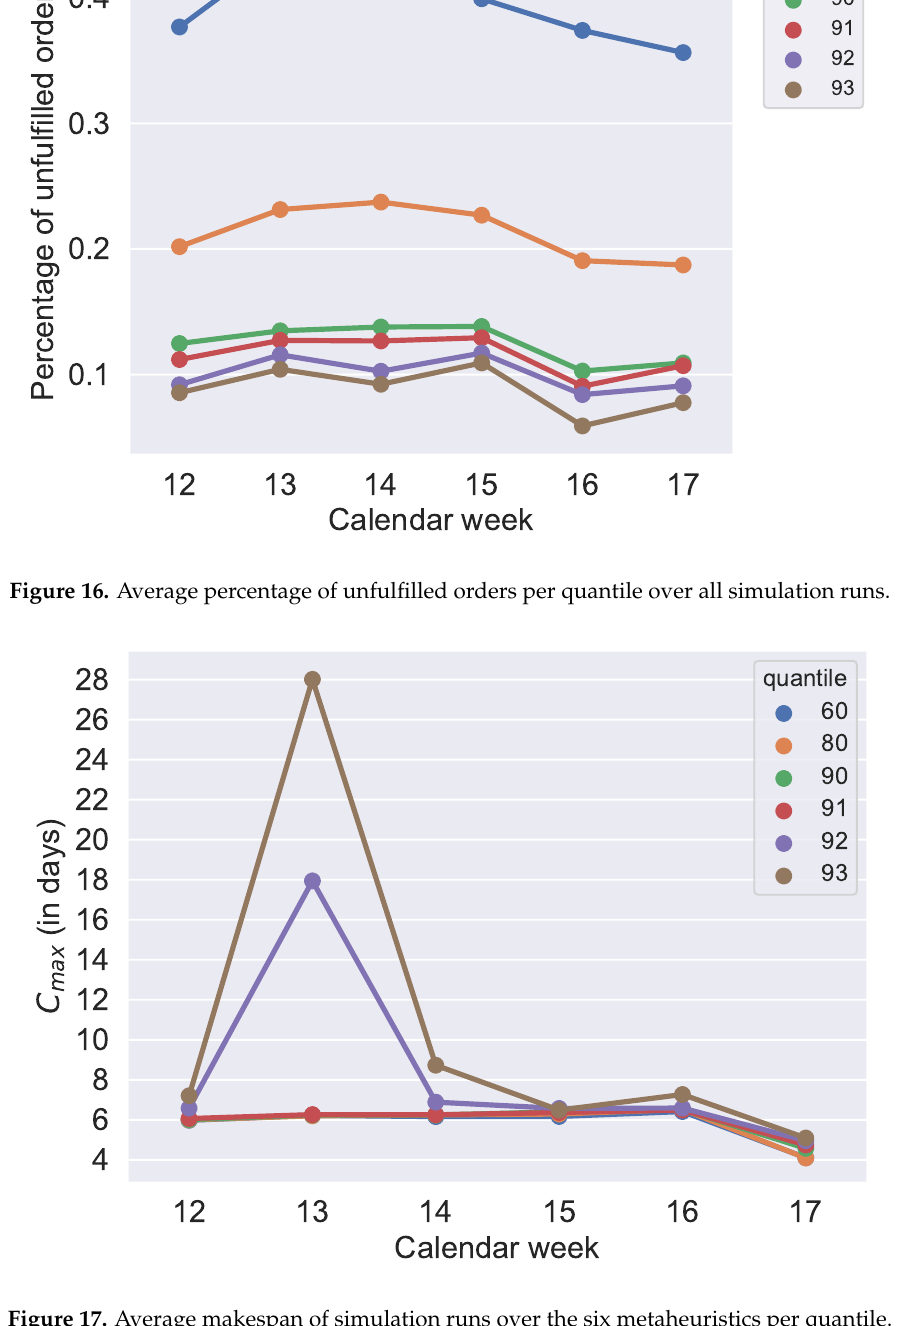
Figure 17. Average makespan of simulation runs over the six metaheuristics per